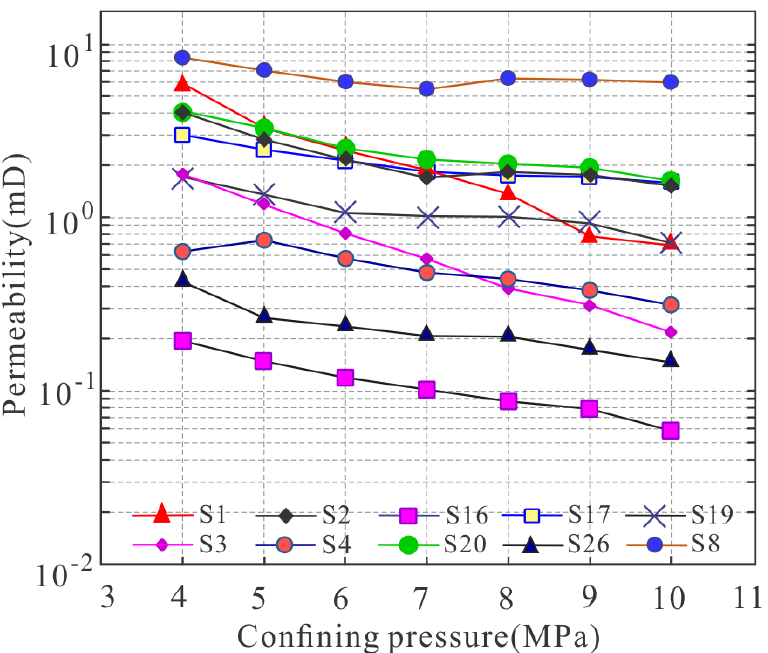
Figure 5. Klinkenberg permeability as a function of confining pressure for all tested samples, yielding a higher sensitivity of the micro-fractured shale samples to pressure changes as compared with the porous and unfractured sandstone (Sample